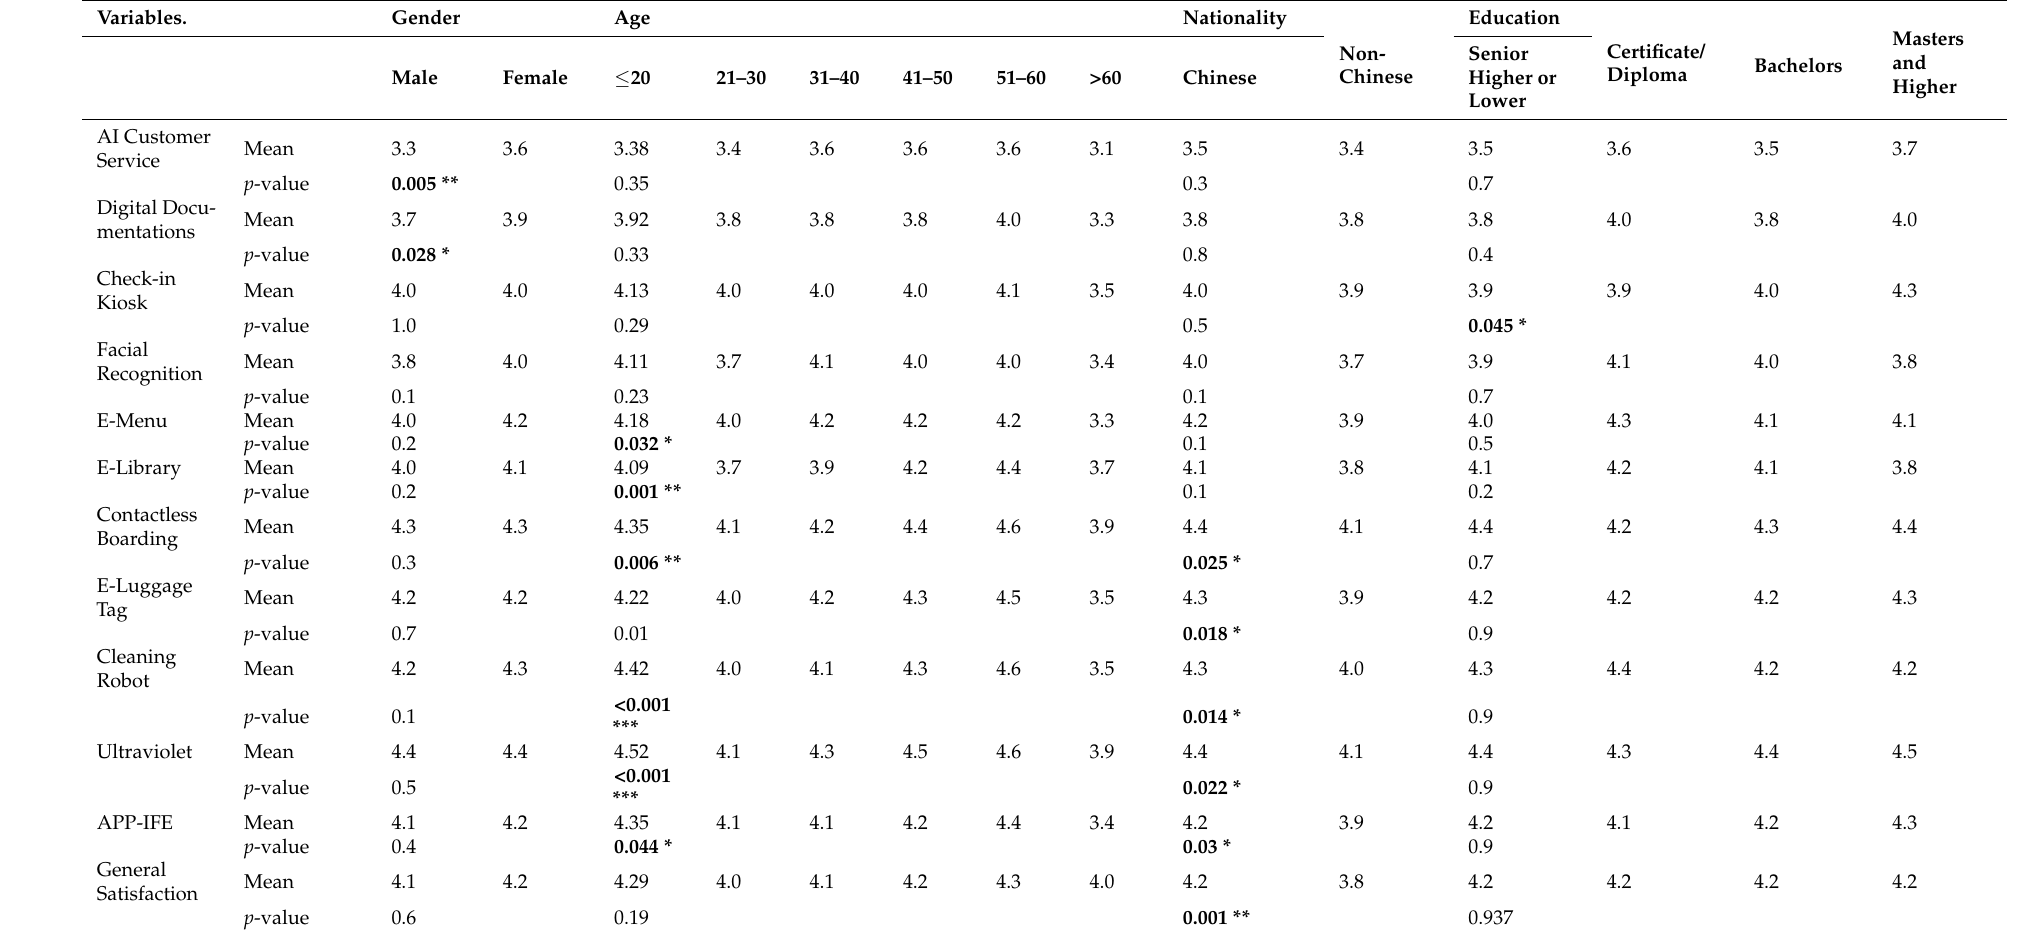
Table A1. ANOVA results for 12 variables show the relationship between gender, age, nationality and education.